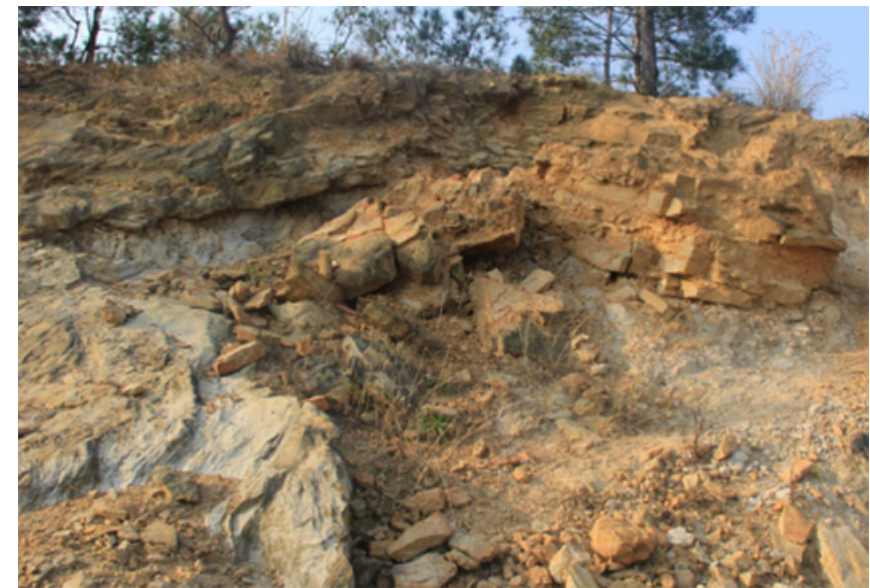
Figure H3. Outcropping of rock strata in the study